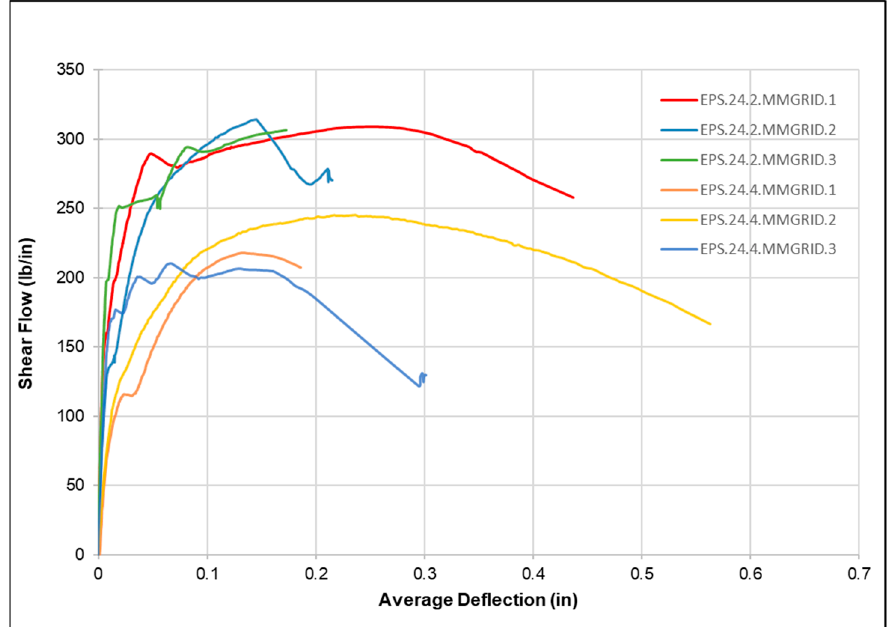
Figure 17. E ff ect of EPS insulation thickness: shear fl ow vs. average de fl ection graph of Figure 17. Effect of EPS insulation thickness: shear flow vs. average deflection graph of EPS.24.2.MMGRID and EPS.24.4.MMGRID specimens. EPS.24.2.MMGRID and EPS.24.4.MMGRID specimens.